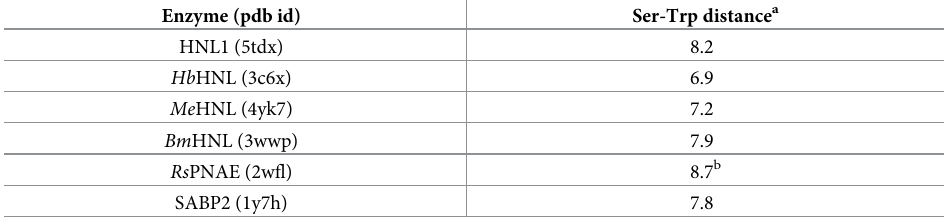
Table 4. Size of the substrate-binding region as measured by the distance between the catalytic serine and Trp128 (or equivalent).